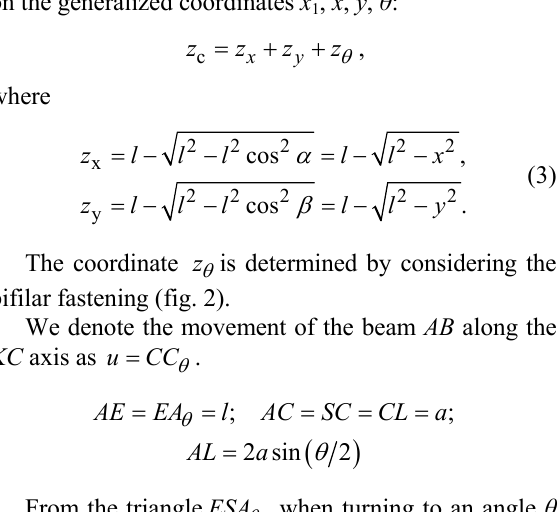
Figure 1. С omputational scheme for the transportation of the beam AB by traverse DE with the usage of bifilar